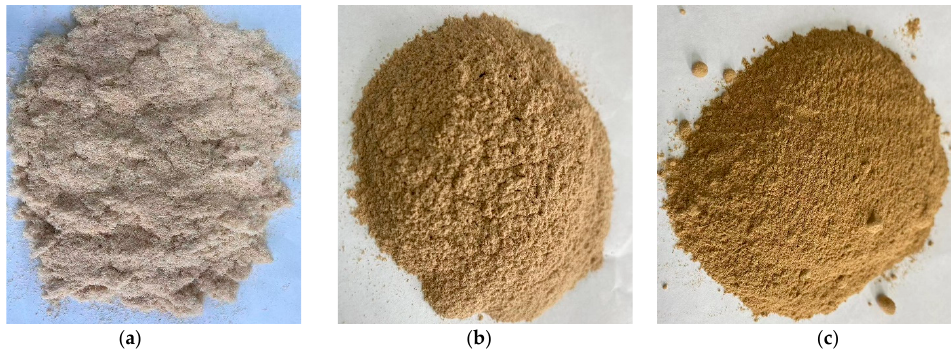
Figure 1. The real photos of different natural fiber powders ( a ) ARP; ( b ) RSP; and ( c ) WF.